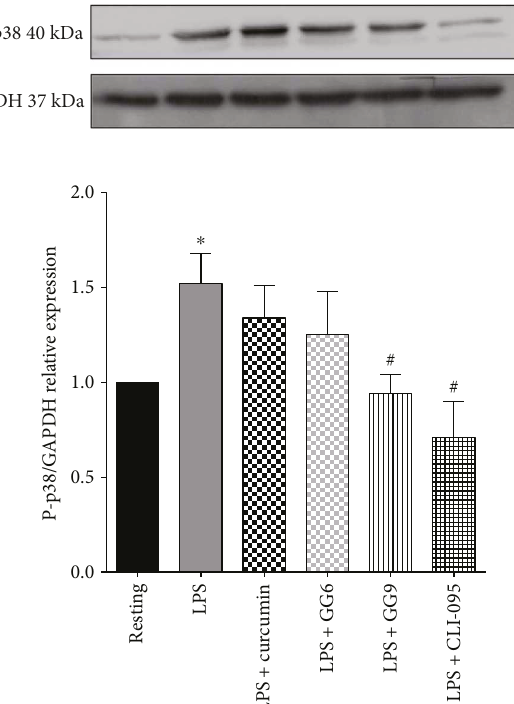
Figure 5: Phospho-p38-MAPK immunodetection in CSF-1-driven macrophages. Total protein extracts from resting, untreated M1, and test agent-pretreated M1 macrophages were assayed after 30min LPS incubation. GAPDH served as loading control. Bars represent the mean ( ± SEM) of 6 independent experiments. Results from representative immunoblots are shown. ∗ p < 0 05 versus resting; # p < 0 05 versus